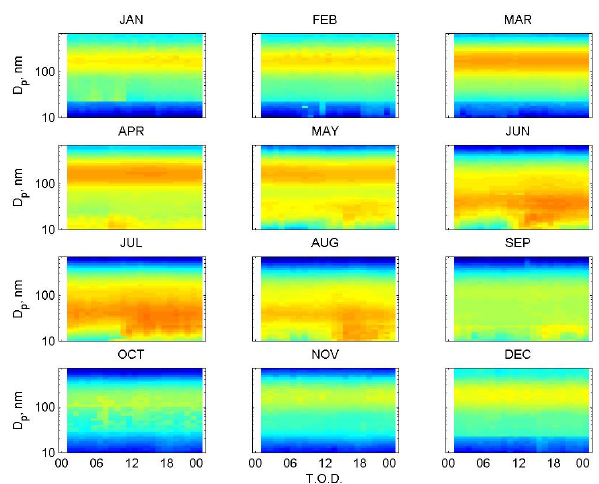
Fig. 11. Monthly diurnal variation of the mean of the aerosol num- ber size distribution. T.O.D. represents “Time of